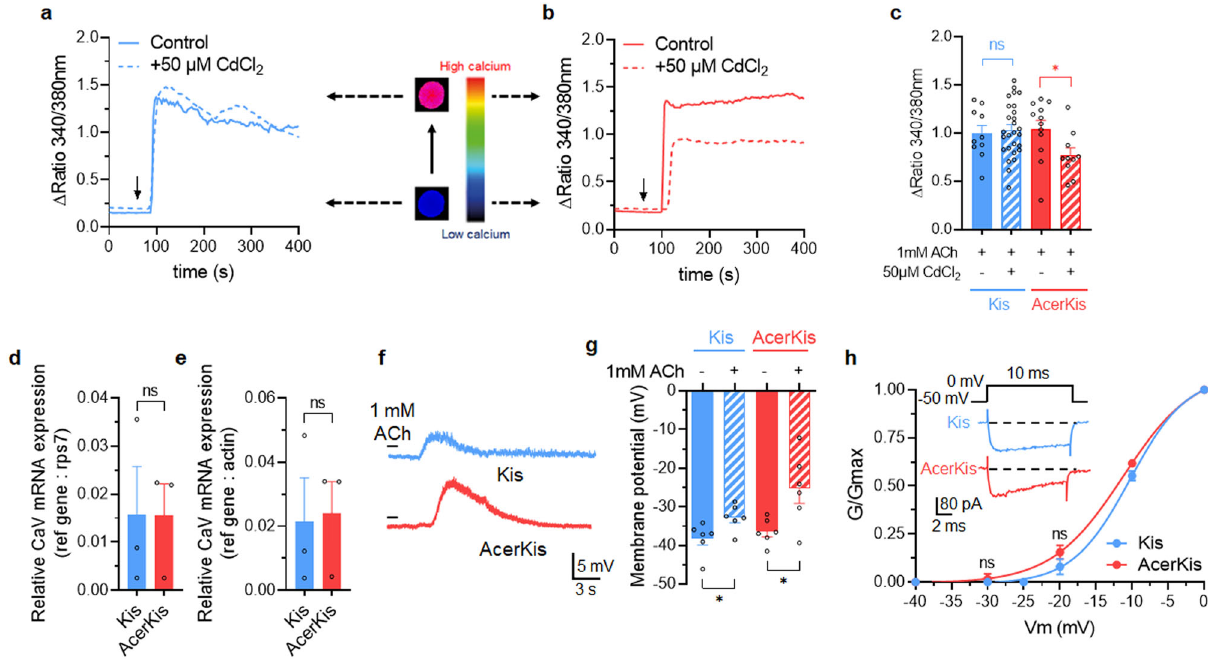
Fig. 4 Acetylcholine activates voltage-dependent calcium channels in AcerKis neurons. a – c Bath application of acetylcholine (ACh, 1 mM) increased intracellular free calcium concentration in Fura-2-loaded Kis ( a ) and AcerKis ( b ) neurons. Pretreatment with the voltage-gated calcium channel blocker CdCl 2 , (50 µ M) signi fi cantly reduced ACh-induced [Ca 2 + ] i rise in AcerKis neurons ( b, c ) but did not produce any effect on [Ca 2 + ] i elevation in Kis neurons ( a , c ). Inset shows images of Fura-2 fl uorescence of a single neuron cell body isolated from Kis and AcerKis strains after application of 1 mM ACh. Bars represent mean ± S.E.M. ( n = 10 – 27 for Kis neurons and n = 10 – 12 for AcerKis neurons). The statistical test used was Student unpaired t -test, * p < 0.05; ns, non-signi fi cant. d , e Comparative histograms illustrating the relative voltage-gated calcium channel mRNA expression in Kis and AcerKis strains. Note that there is no signi fi cant difference in the relative mRNA expression of calcium channels between Kis and AcerKis strains. Bars represent mean ± S.E.M. ( n = 4). The statistical analysis was made by using Analysis of Variance (one-way ANOVA), ns, non-signi fi cant. f Effects of ACh on Kis and AcerKis neuronal nAChRs studied under current-clamp condition. Pulse application of ACh (1 mM, 3 s in duration) produced a membrane depolarization in AcerKis